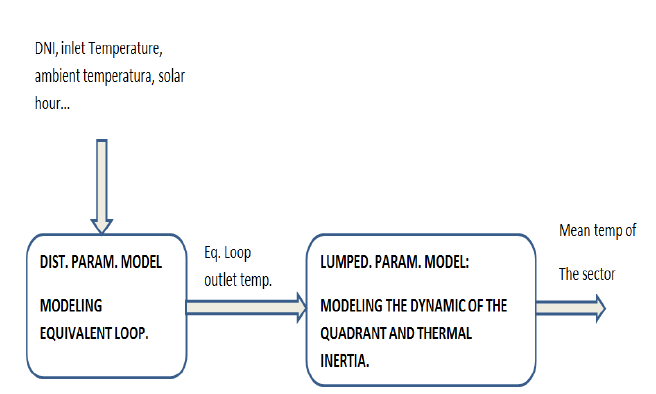
Figure 2. Modeling procedure for a